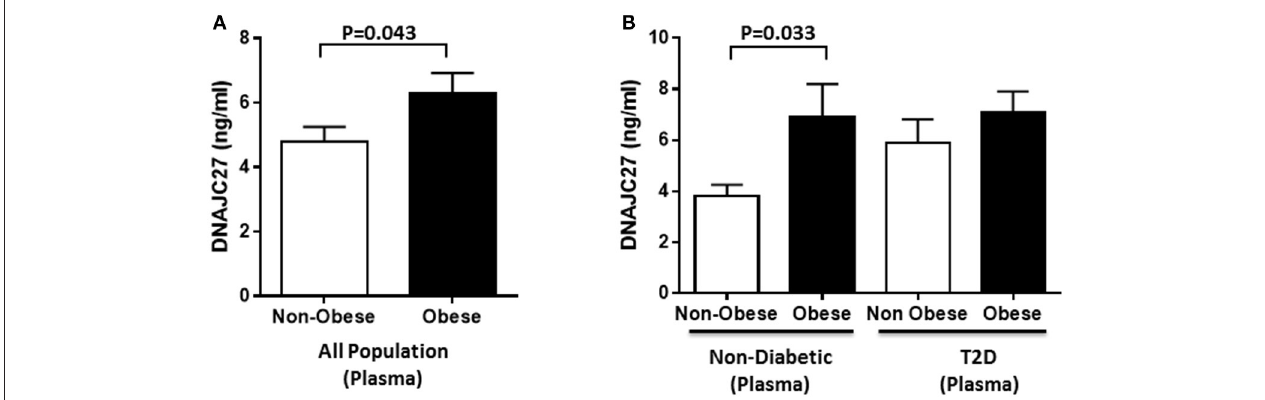
FIGURE 1 | DNAJC27 Level in plasma comparing obese to non-obese individuals. (A) Plasma level of DNAJC27 in all population ( n = 277). (B) Plasma level of DNAJC27 in non-diabetic ( n = 160) and in T2D ( n = 117).